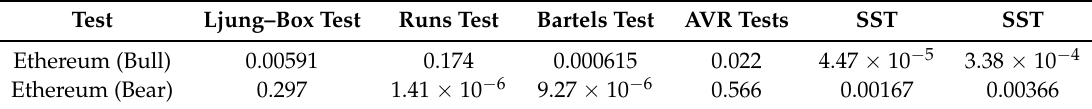
Table 3. Market-efficiency test for hourly returns of Ethereum during bull and bear market.